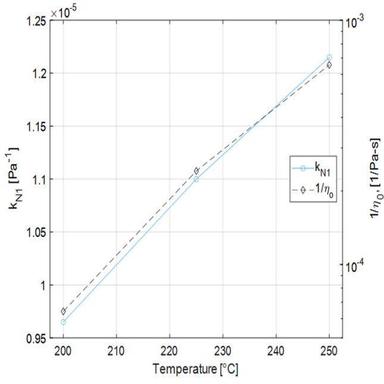
kN1 and 1/η0 as a function of hot end temperature setpoint.